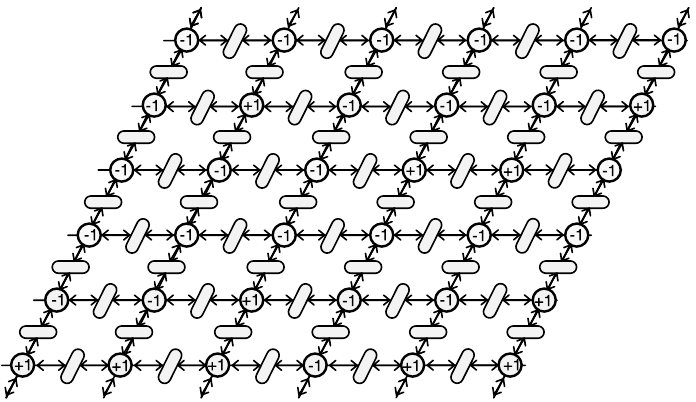
Figure 2. Binary Quadratic Net for 2D-Array Ising Model shown in Figure